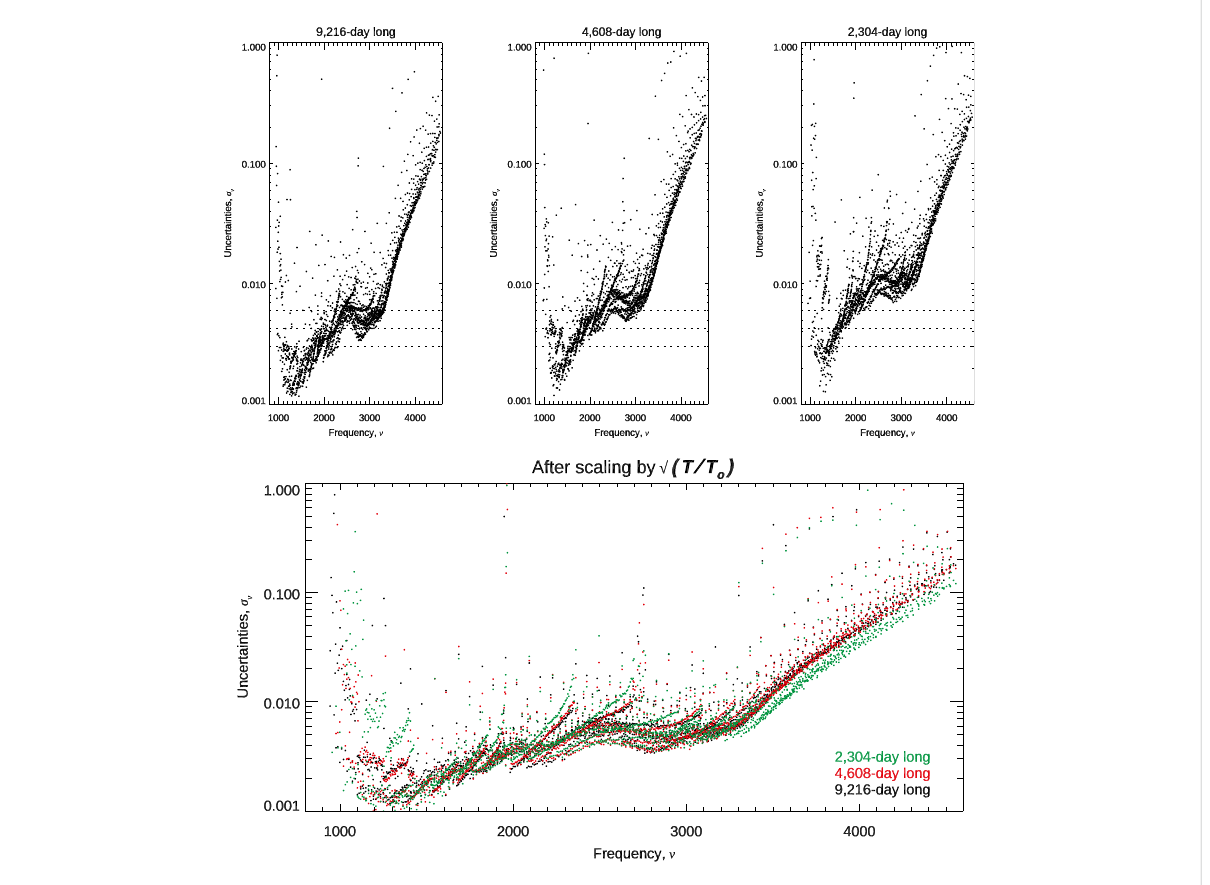
FIGURE 13 Comparison of multiplets ’ frequency uncertaintiesresulting from fi tting 9,216-, 4,608-, and 2,304-day-long time series ofGONG observations (top panels, left to right). The bottom panel shows how well these scale with the expected the low and high